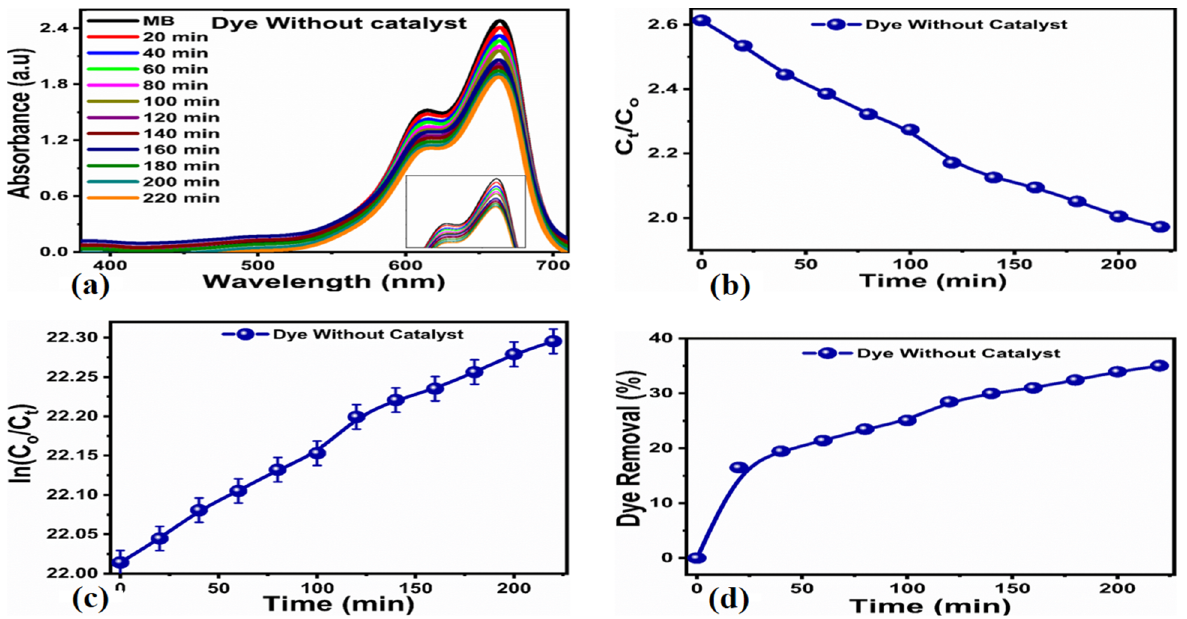
Figure 5. Graphs for MB dye without any catalyst. ( a ) Absorption spectra, ( b ) Ct/Co curve, ( c ) kinetics of degradation, and ( d ) efficiency of dye removal.